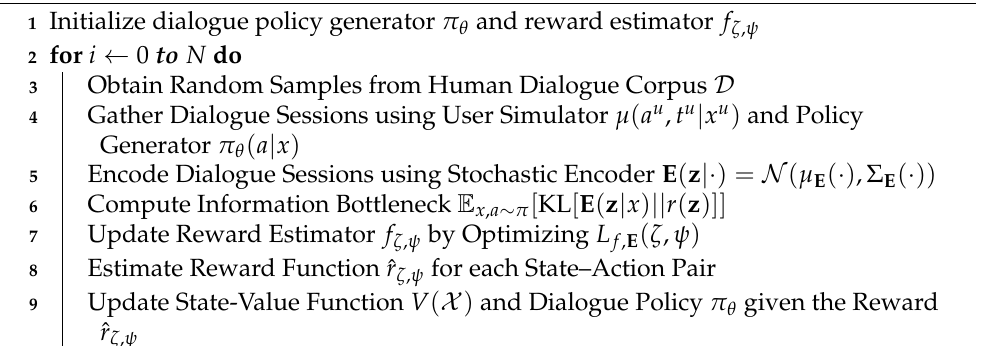
Algorithm 1 Algorithm of Variational Reward Estimator Bottleneck